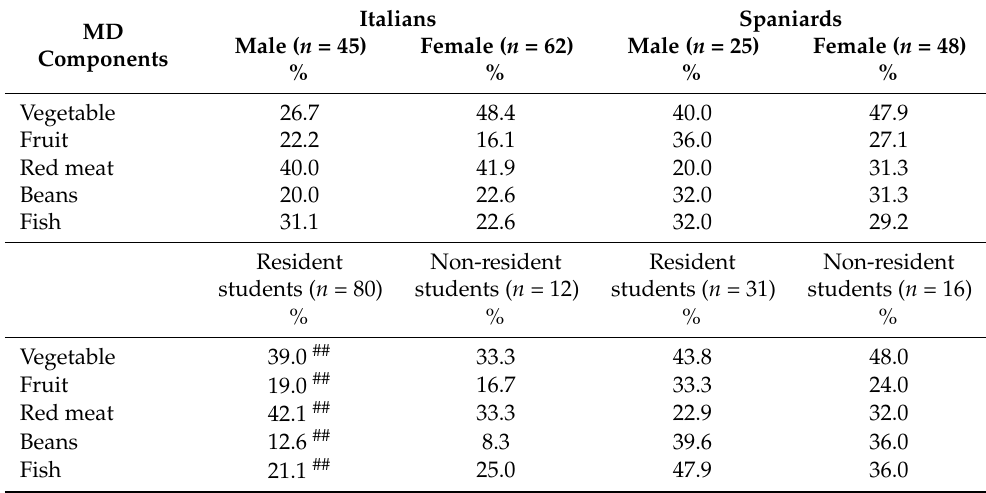
Table 4. Percentage of students who complied with the recommended portion of Mediterranean diet components.